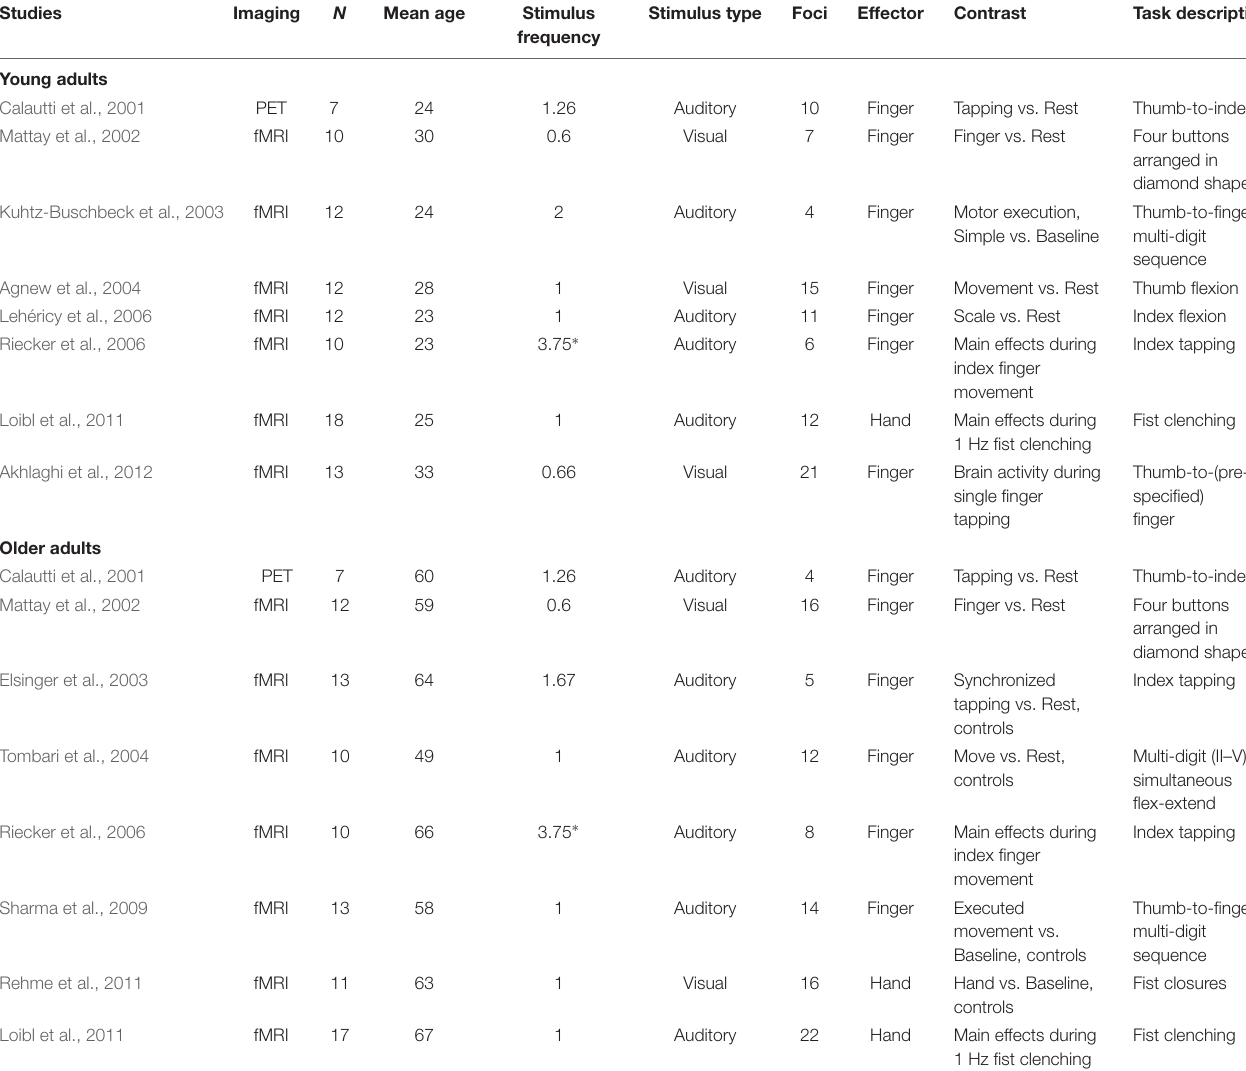
TABLE 2 | Meta-analysis